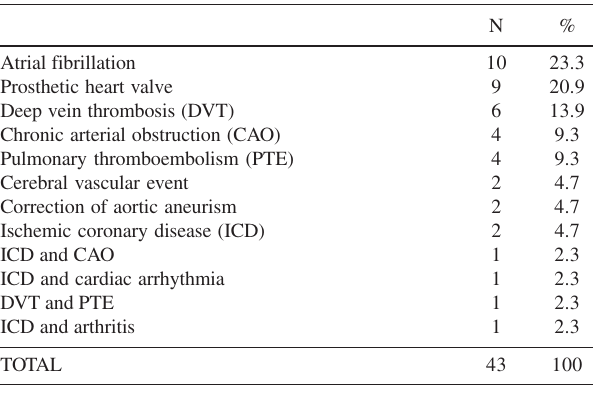
Table 2 - Reason for oral